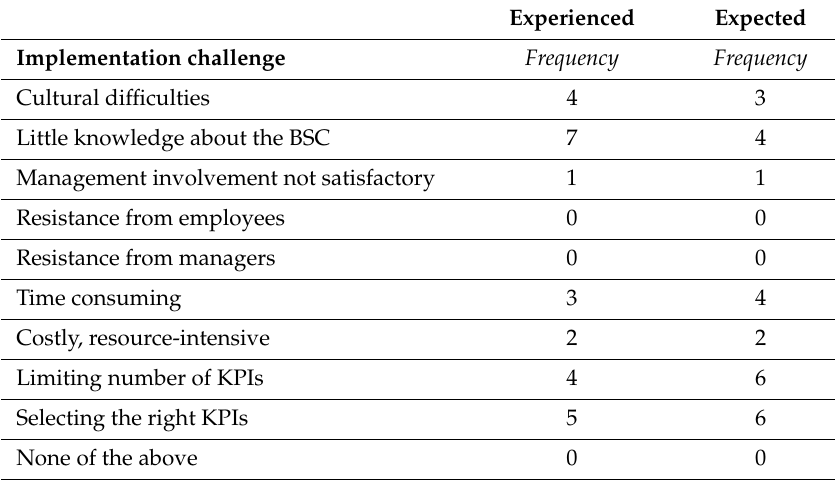
Table 15. Experienced vs. expected implementation challenges (N =